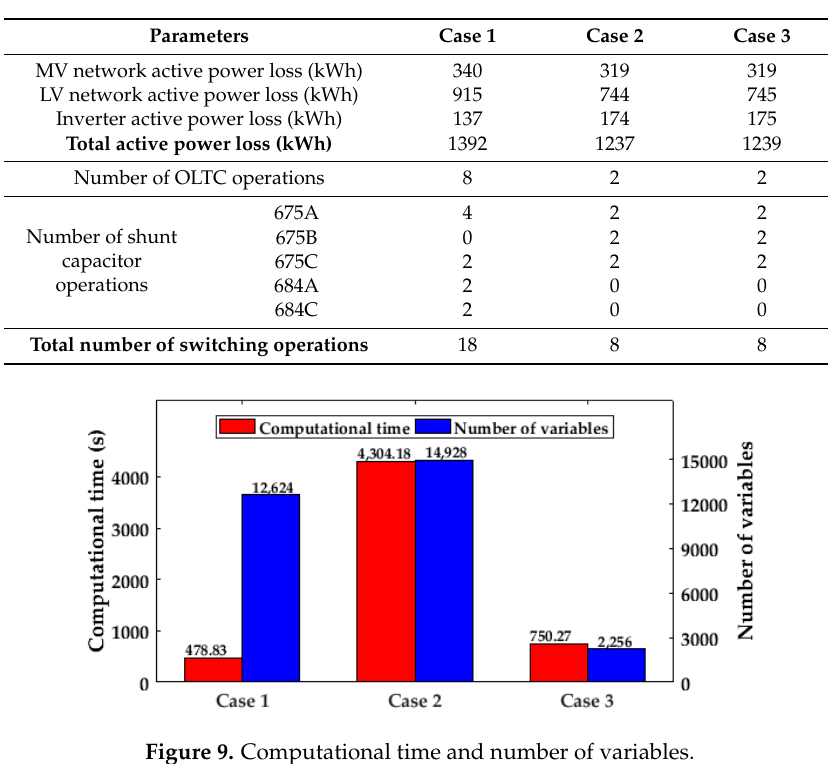
Figure 9. Computational time and number of variables.